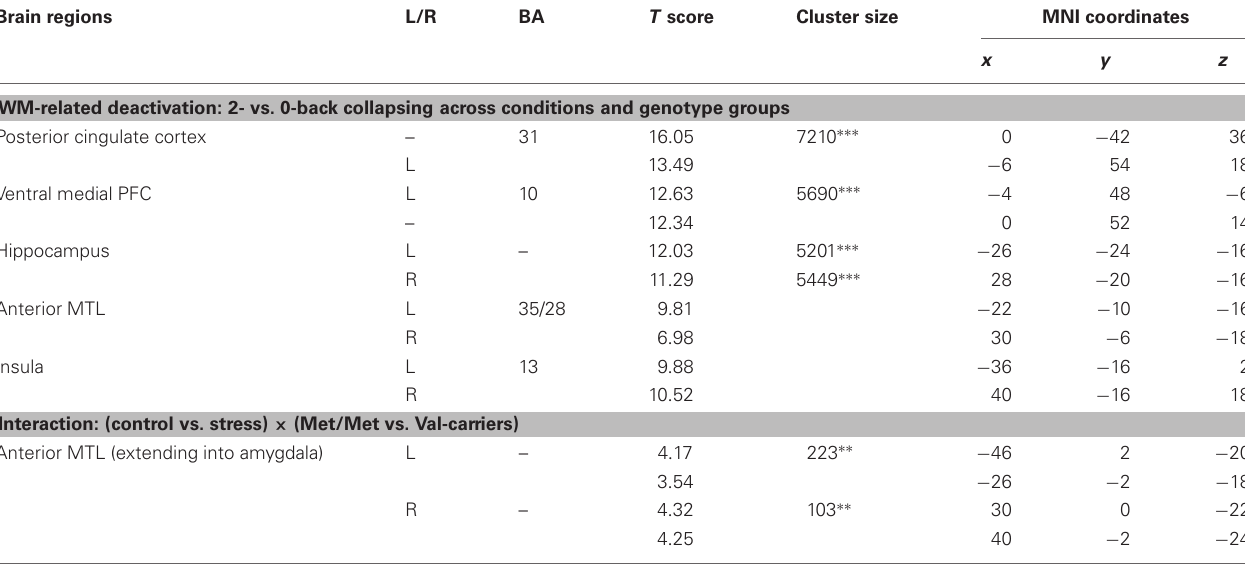
Table 5 | Brain deactivations related to WM, and modulations of stress and COMT genotype. Brain regions L/R BA T score Cluster